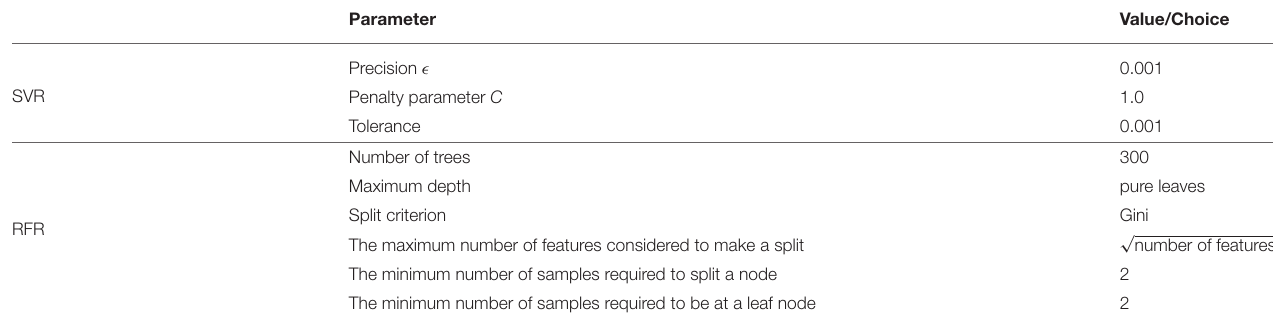
TABLE 2 | Optimized ML parameters of SVR and RFR (scikit-learn library, cf. Pedregosa et al., 2011) for prediction of microstructural features from flow